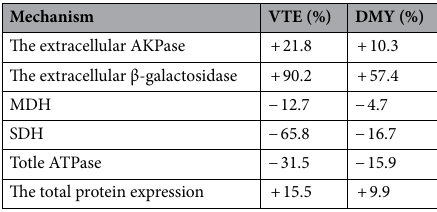
Table 1. The mechanism of VTE and